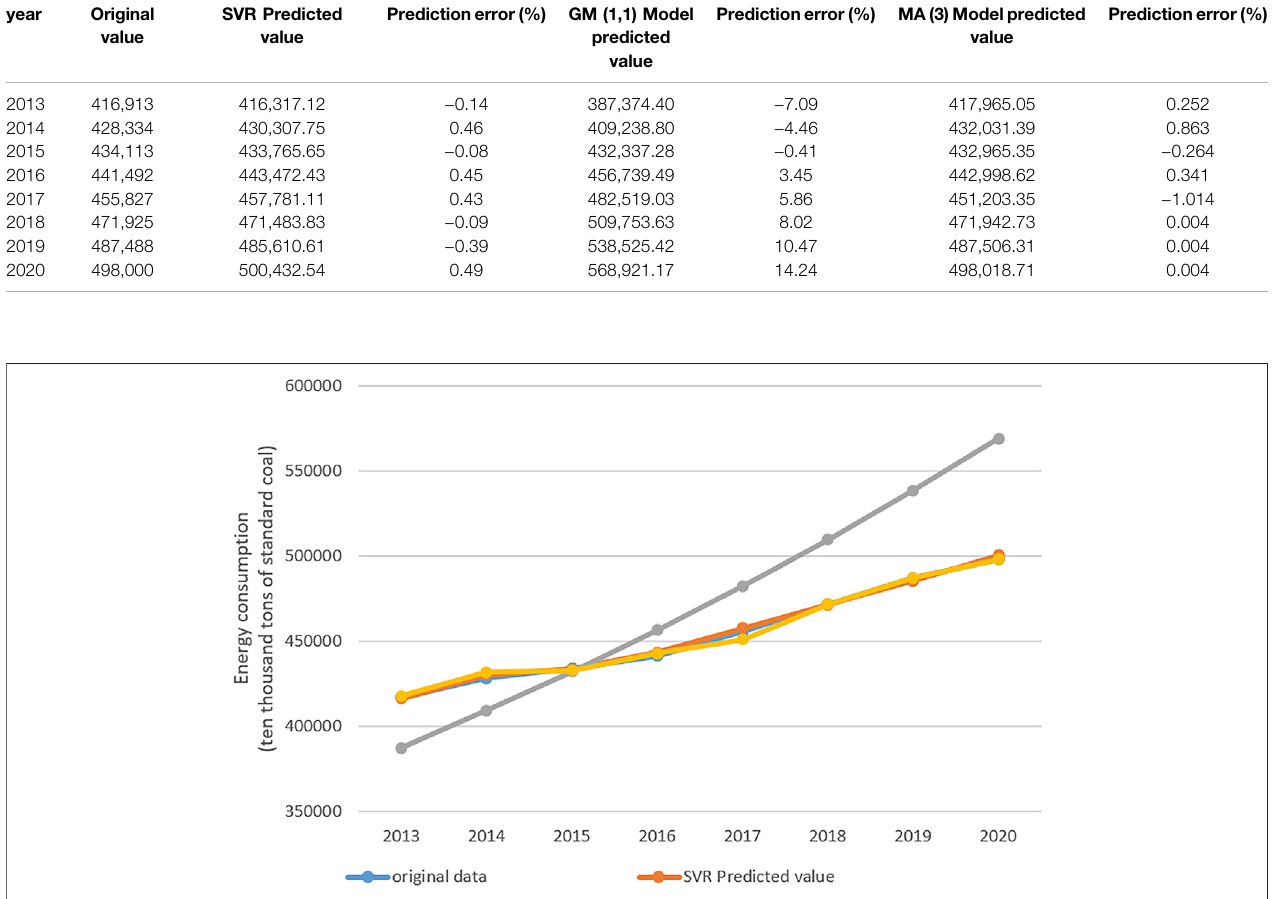
TABLE 4 | Simulation of energy consumption in China by SVR, GM (1, 1) and MA (3) model (Unit: ten thousand tons of standard coal).